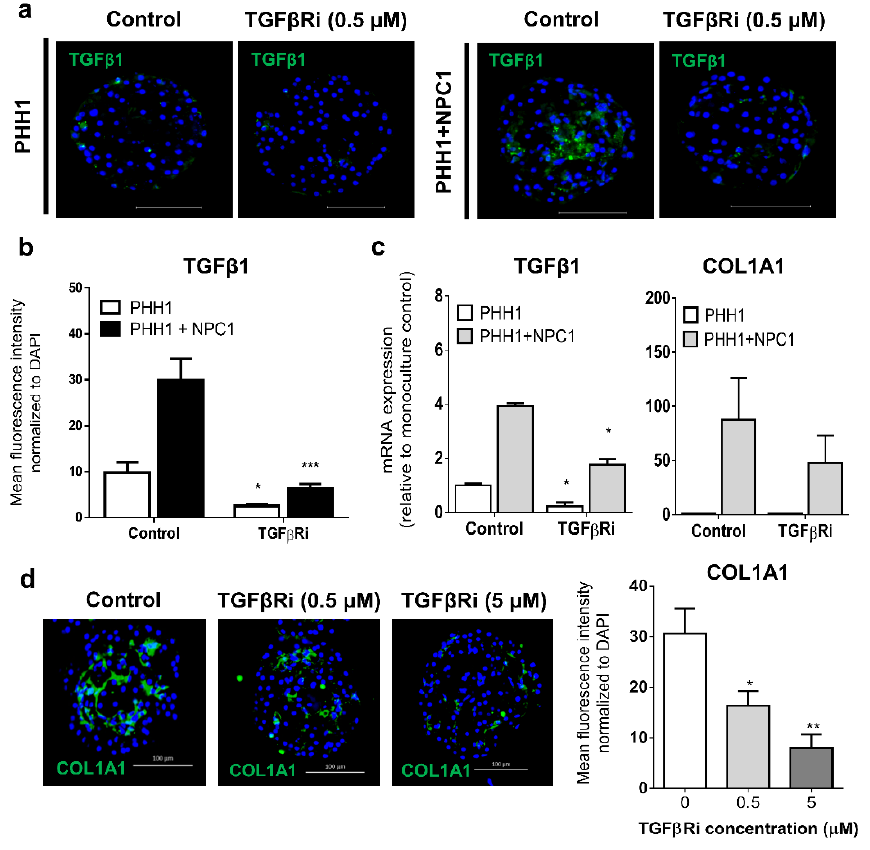
Figure 4. Regulation of fibrogenic outcomes by a TGFβ1 receptor inhibitor. Endogenous protein expression of TGFβ1 was high in donor 1 co-cultures but reduced following 72 h exposure to a TGFβRi ( a , b ) with a similar impact evident on mRNA expression of TGFβ and COL1A1 in co-cultures from donor 1 ( c ). The continuous exposure of TGFβRi for 7 days inhibited COL1A1 protein expression in a dose-dependent manner ( d ). * p < 0.05, ** p < 0.01.